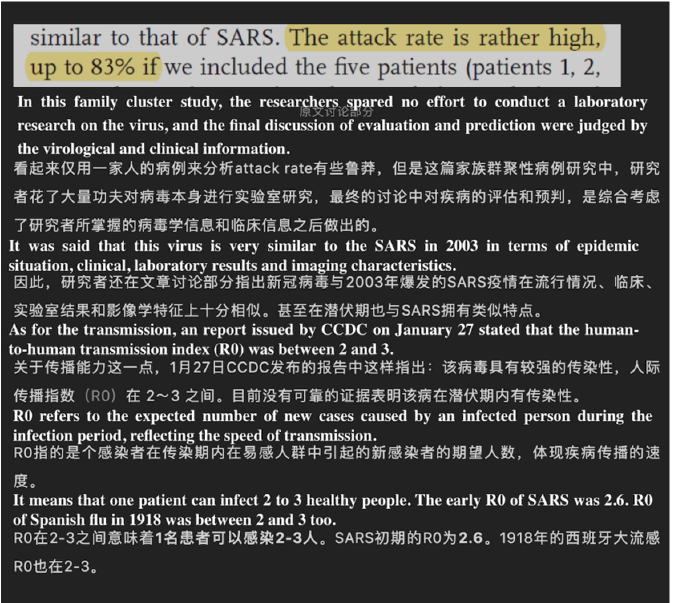
Figure 6. Screenshot of a science article. From: JieDi. What do you think of The mortality rate of the first 41 infected cases reached 15%? The Chinese CDC report is here. Available online: https://mp.weixin.qq.com/s?__biz=MjM5MDc3NjQwMA==&mid=2926680516&idx=4&sn=5510955bfd633041960d364d6a99abfe&chksm=8d3a94fbba4d1ded116d78153c87dcc4c6ed1554927187aab9af452f